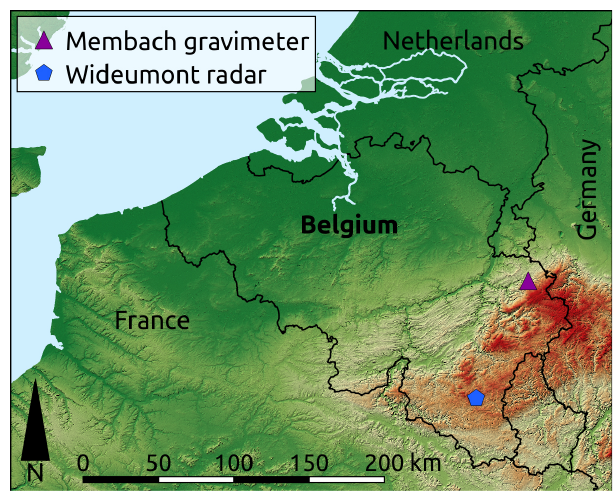
Figure 1. Locations of gravimeter and weather